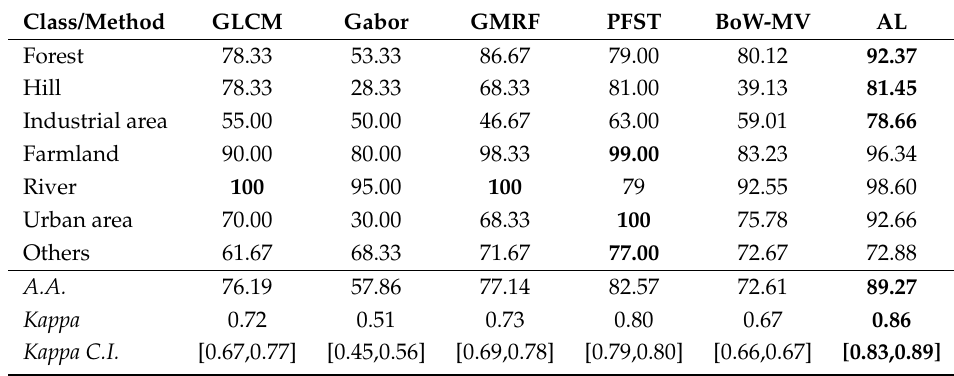
Table 2. Performance comparison in terms of accuracy, average accuracy, Kappa coefficient and associated confidence